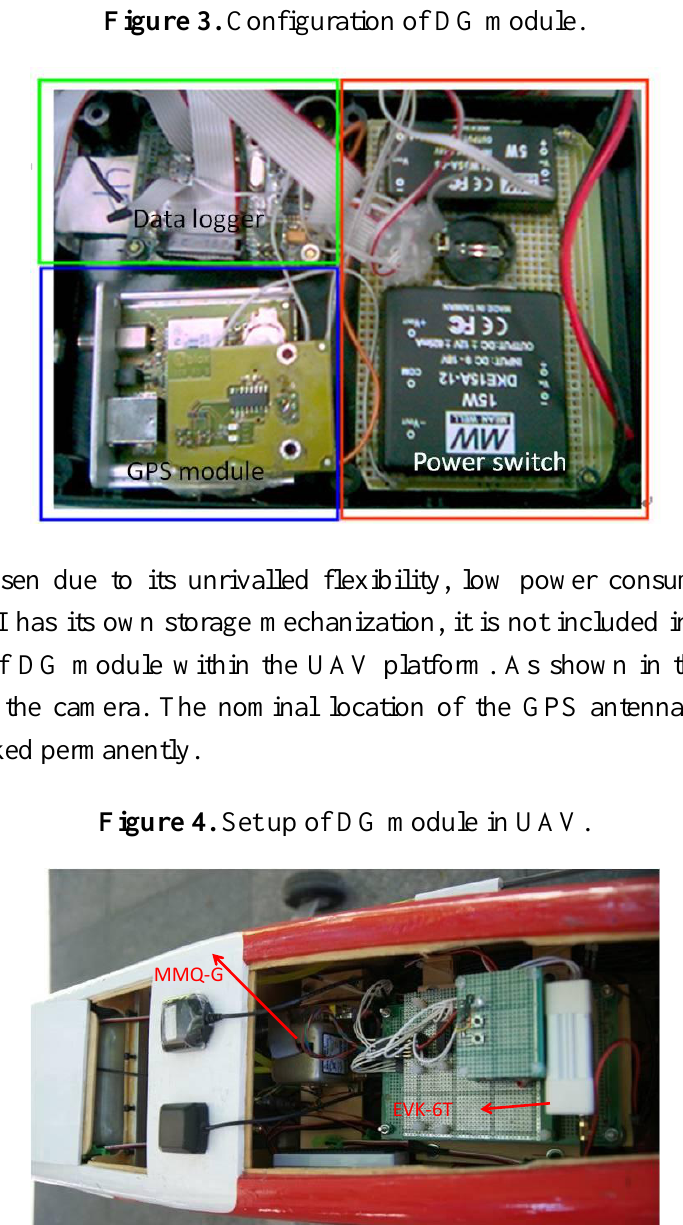
Figure 3. Configuration of DG module.